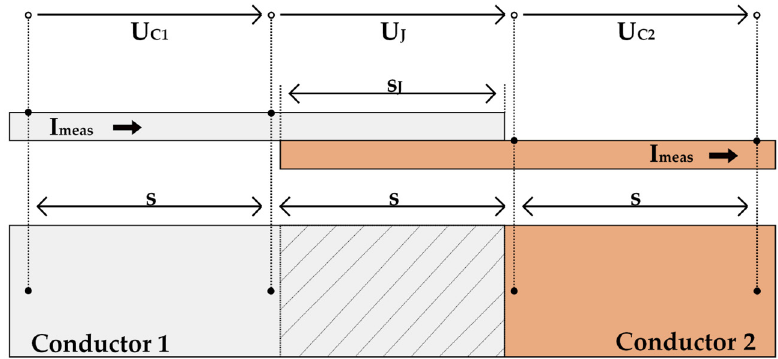
Figure 2. Schematic illustration for the calculation of the contact quality index (CQI).